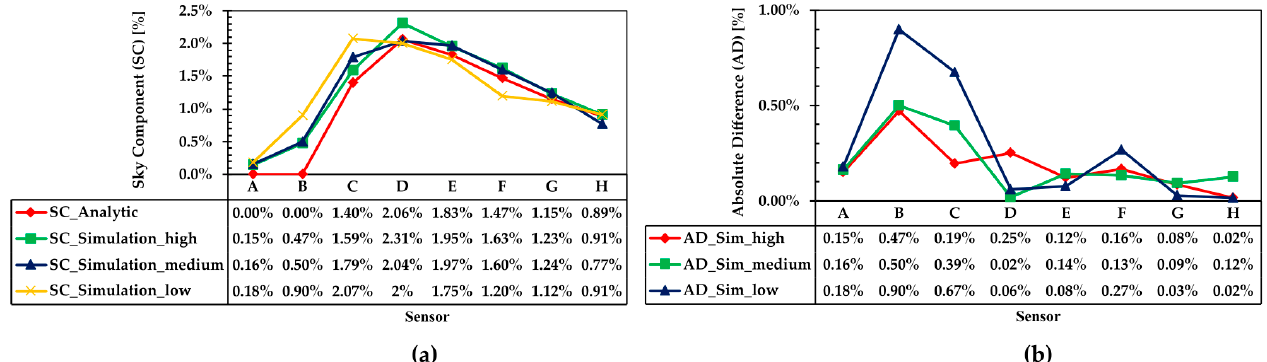
Figure 4. ( a ) Analytical and simulation SC values and ( b ) absolute difference at all calculation points inside the original model of the CIE test case 5.13 (Figure 1a).